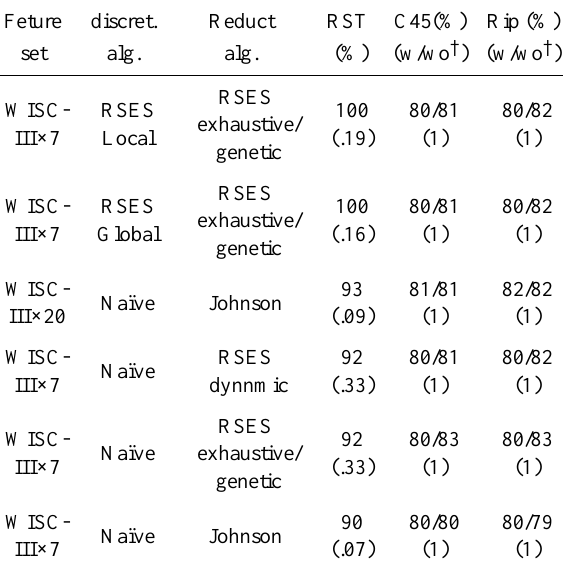
Table 10. Five-fold cross validation results of experiment 2 on data set C using rough set, C4.5, and Ripper algorithms. Only combination(s) of discretization and reduct algorithms that achieve better rule quality (by RST) in terms of certainty and coverage (listed in parentheses) are shown.